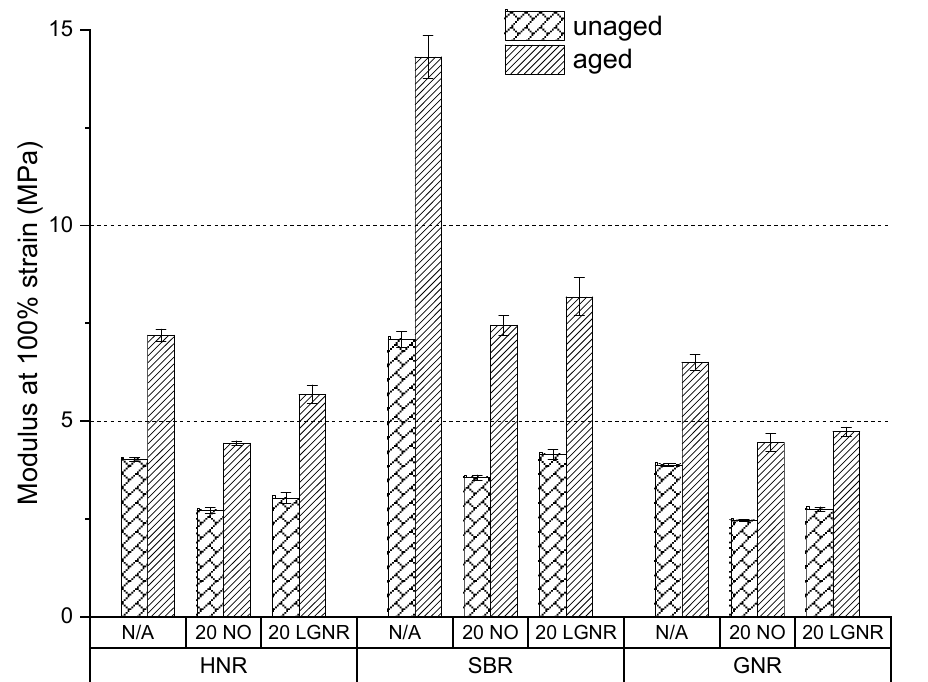
Figure 17. Aging effects on the modulus at 100% strain (M100) of HNR, SBR and GNR composites made with or without processing aids. N/A: rubber compounds without processing aids; 20 NO: rubber compounds with 20 phr naphthenic oil; 20 LGNR: rubber compounds with 20 phr liquid guayule natural rubber.